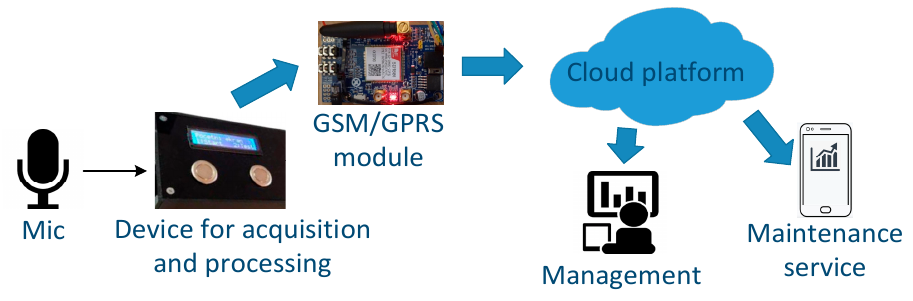
Figure 7. The proposed system architecture.